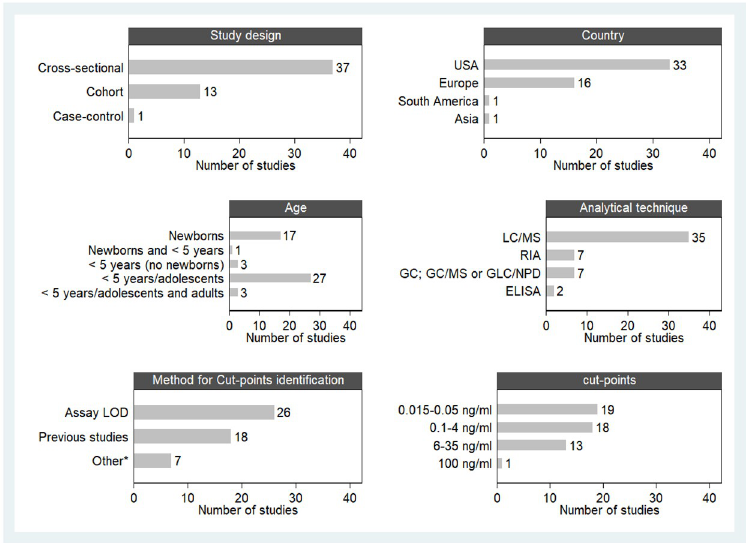
Fig 2. Study and population characteristics (design, country; age); analytical technique for serum cotinine quantification (isotope dilution-liquid chromatography-tandem mass spectrometry (LC/MS), radioimmunoassay (RIA), gas chromatography (GC), gas-chromatography mass spectrometry (GC/MS), gas-liquid chromatographic procedure with nitrogen-phosphorus-specific detector (GLC/NPD) and enzyme-linked immunosorbent essay (ELISA)); cut-point values range (ng/ml) and methods for cut-point identification (assay limit of detection (LOD), previous studies or other (separation point in the bimodal distribution, median cotinine levels of the cohort, receiver operating characteristic (ROC) curves or